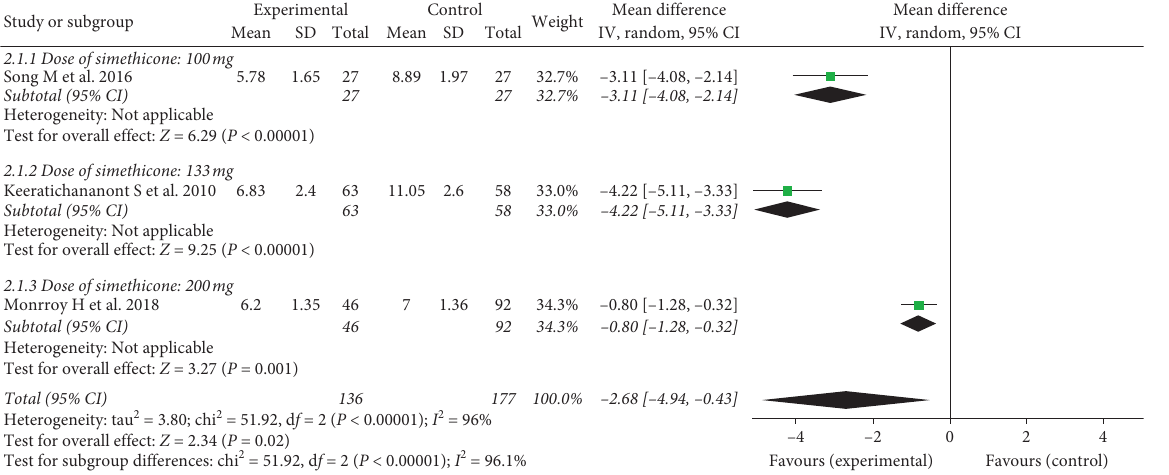
Figure 7: Forest plot of subgroup analysis of the effect of the dose of simethicone on the mean difference in TMVS between simethicone and control agents.